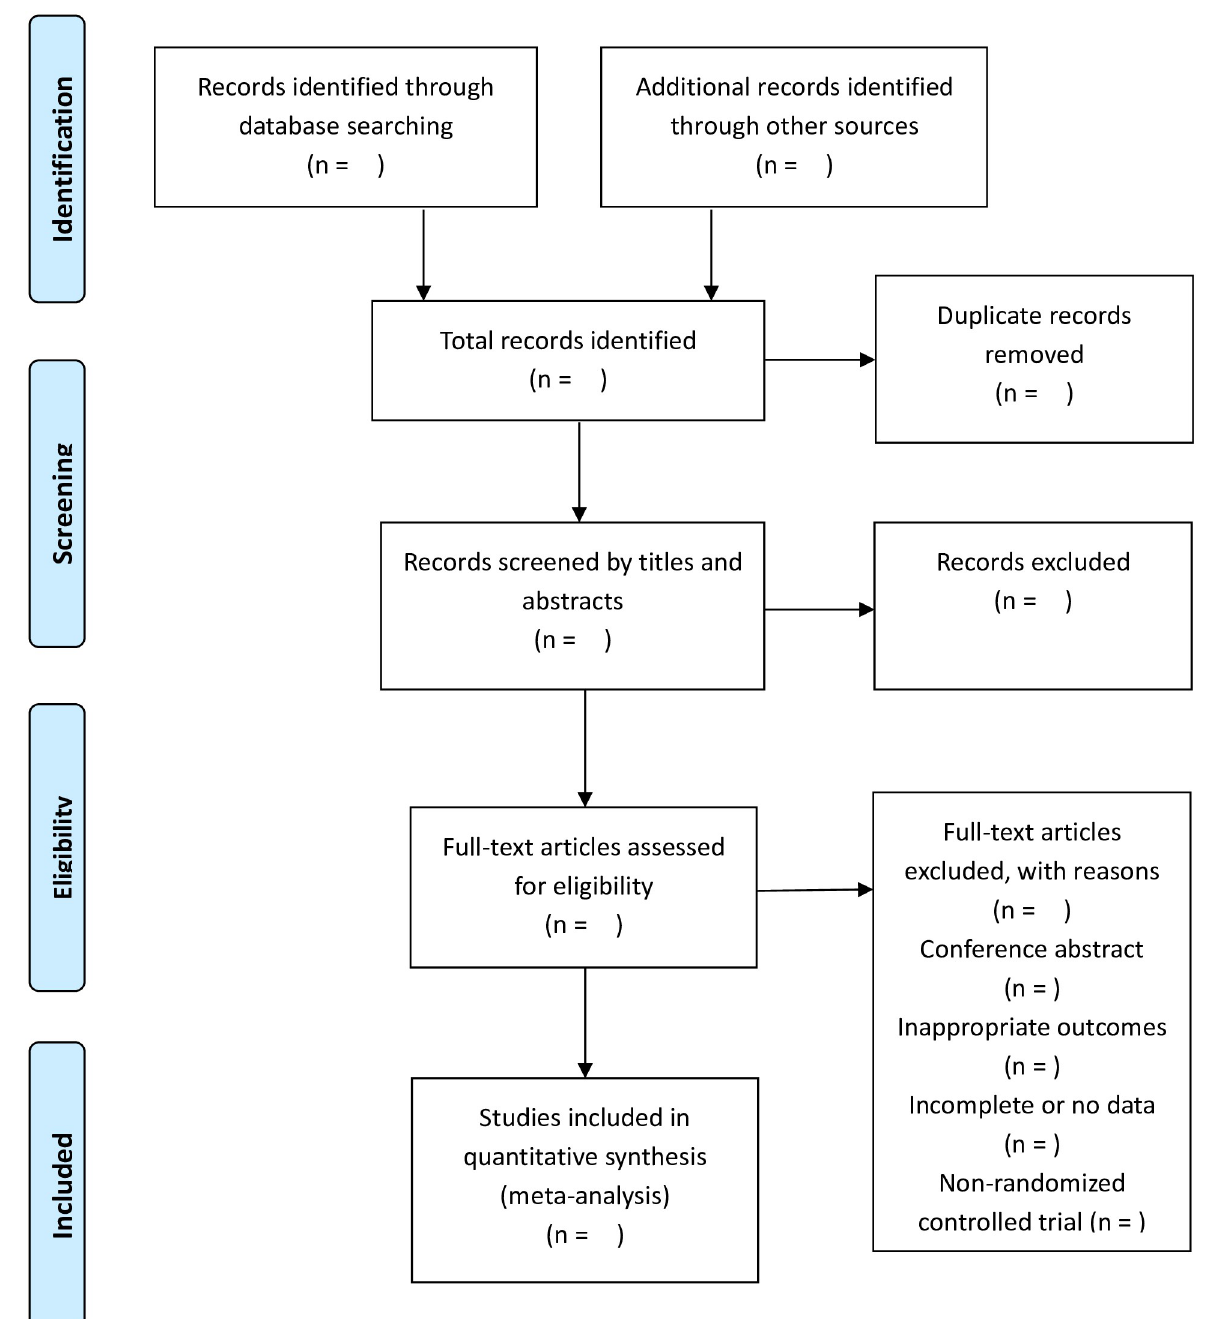
Fig 1. Flow diagram of study selection